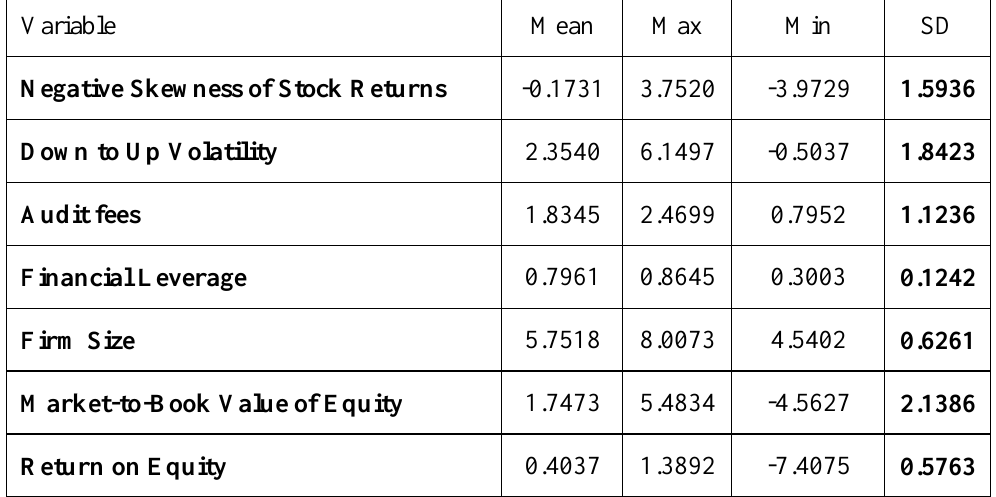
Table 1. Descriptive